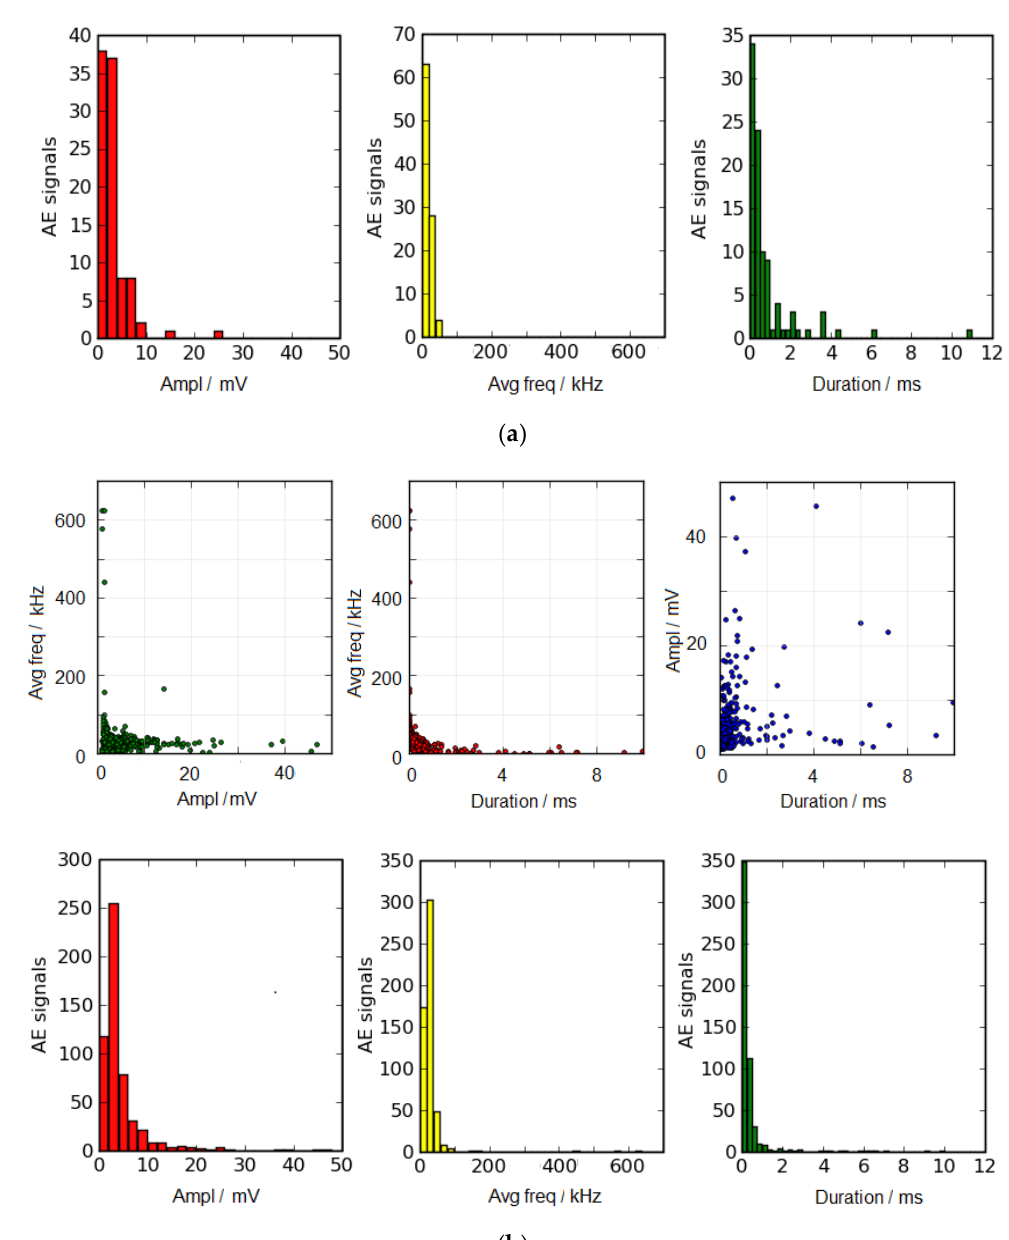
Figure 6. ( a ) AE features relationships and distributions of received signals by sensors AE0 and AE1. The mean values of distributions represented by histograms from left to right are: < A > = 3.3 mV, < f > = 17 kHz, and < Δt > = 0.8 ms. ( b ) AE features relationships and distributions of received signals by sensors AE4 and AE5. The mean values of distributions represented by histograms from left to right are: < A > = 4.5 mV, < f > = 31 kHz, and < Δt > = 0.4 ms.